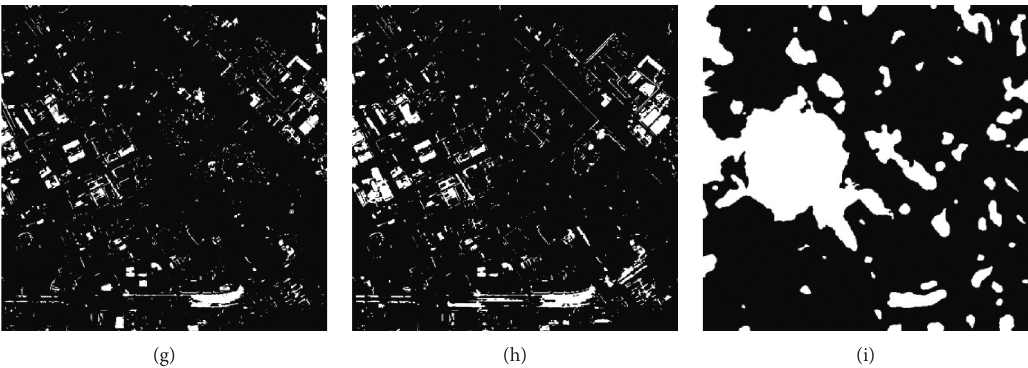
Figure 5: CD maps of dataset 3: (a-b) dataset 3; (c) reference map of dataset 3; (d–i) CD maps obtained in dataset 3 using the proposed method and Methods 1, 2, 3, 4, and 5, respectively.